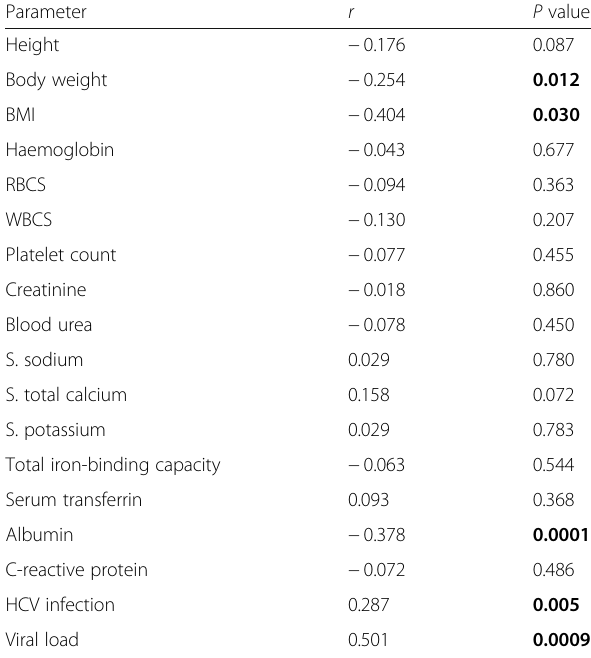
Table 6 Correlation of the MIS with demographic and laboratory